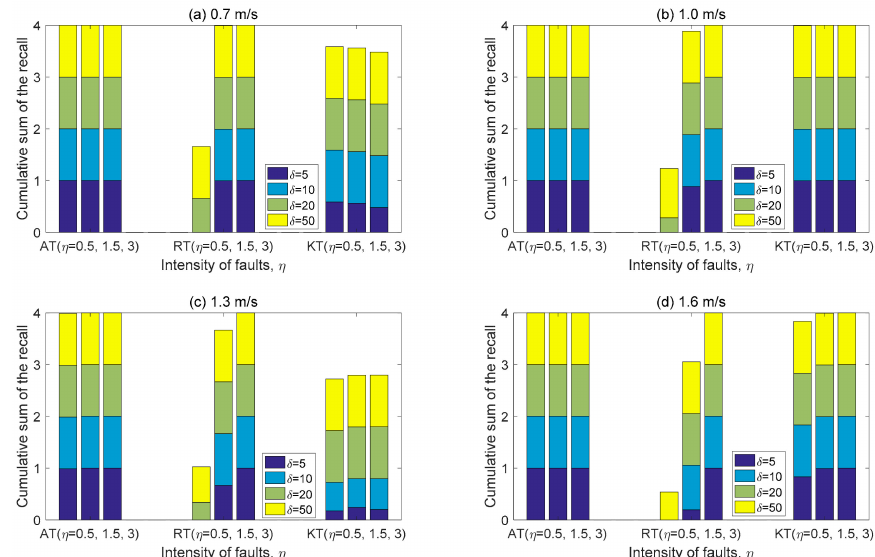
Figure 11. Recall according to each duration as a function of noise fault intensity: ( a ) Cumulative sum of the recall at 0.7 m/s of Jackal UGV; ( b ) Cumulative sum of the recall at 1.0 m/s; ( c ) Cumulative sum of the recall at 1.3 m/s; ( d ) Cumulative sum of the recall at 1.6 m/s.